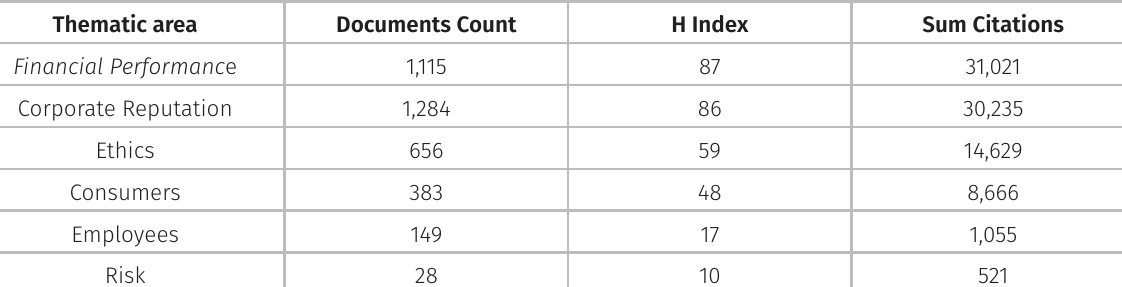
Table IX. Performance of the thematic